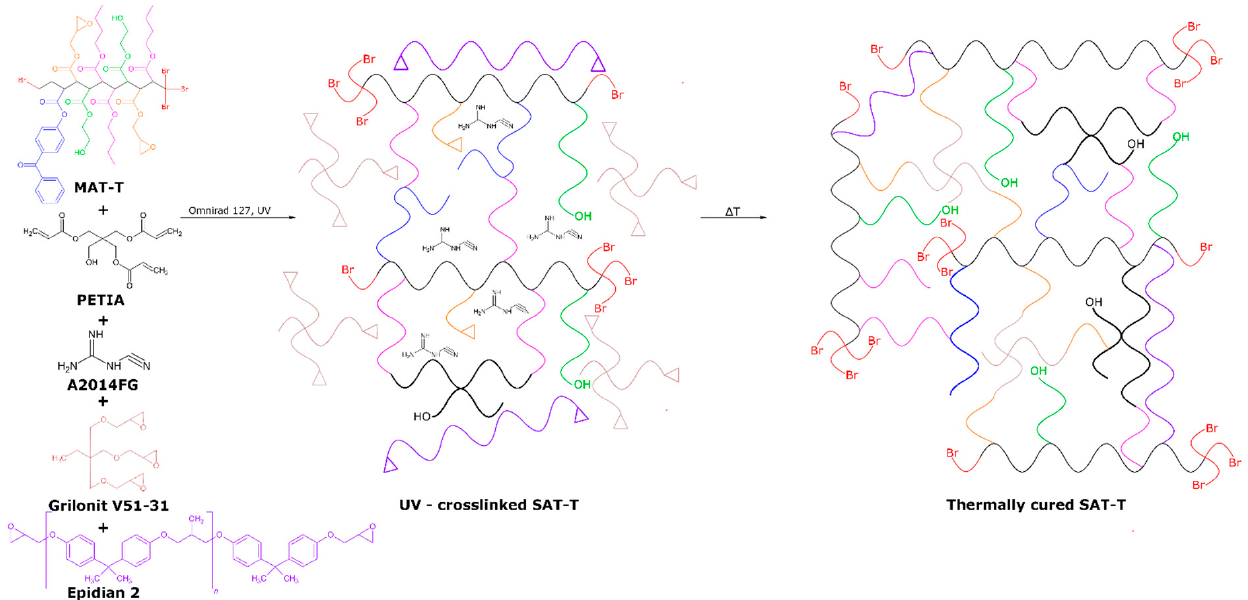
Figure 4. Preparation steps of UV-crosslinked SATs and thermally cured SATs.